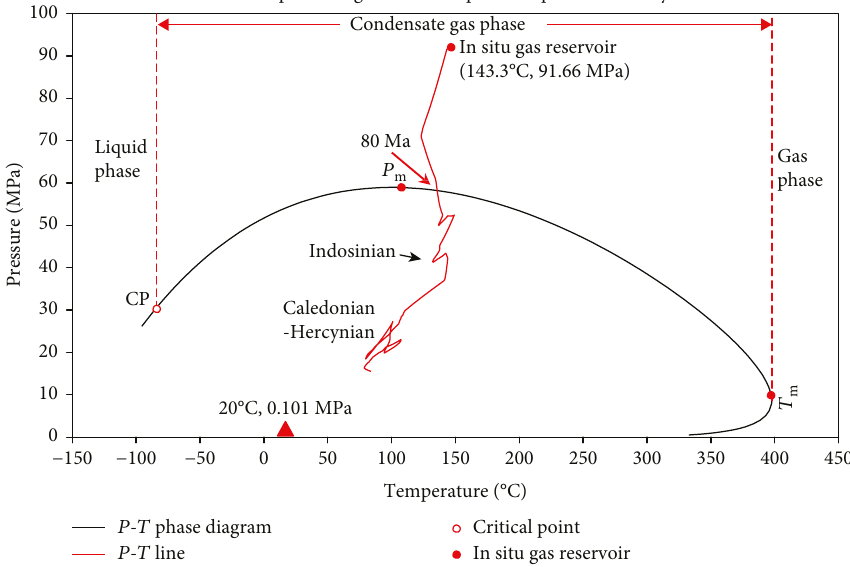
Figure 9: The fl uid phase evolution diagram of the Lianglitage Formation (O